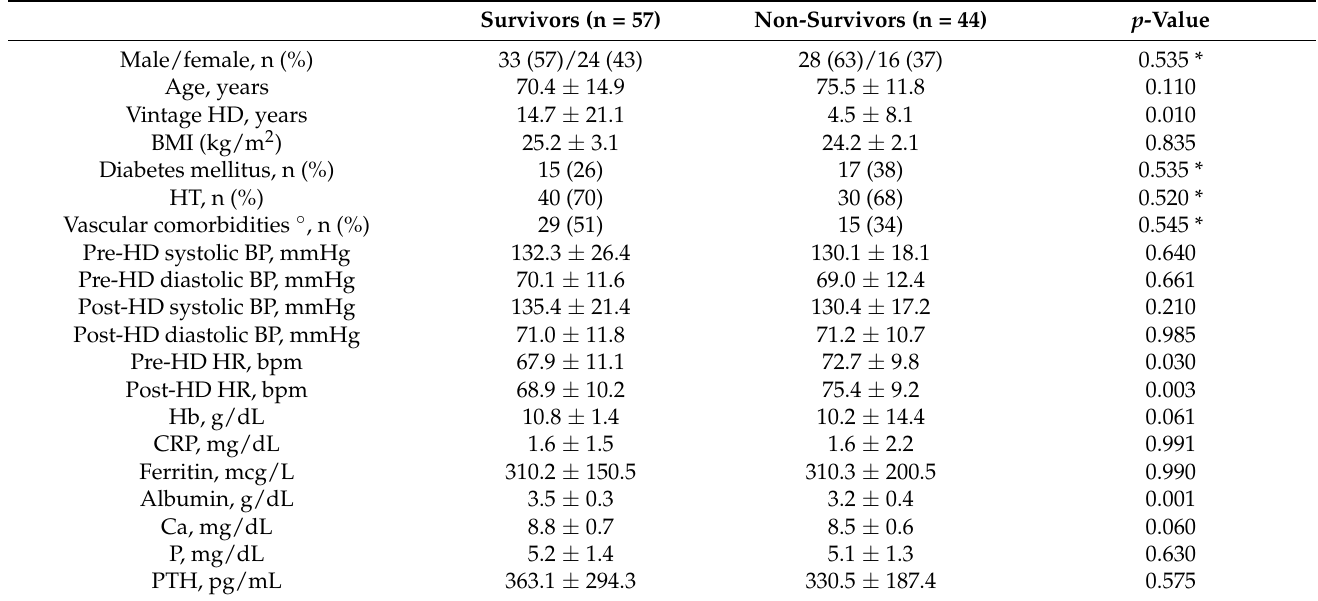
Table 3. Characteristics of survivors and